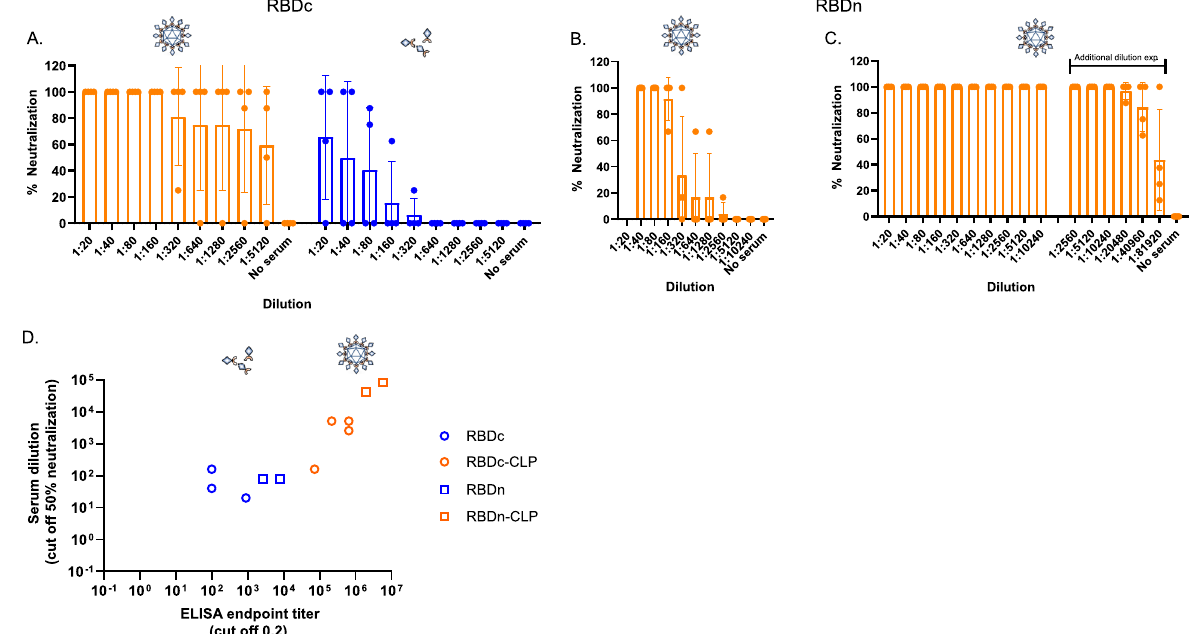
Fig. 5 Serum from mice immunized with RBD-CLP vaccines neutralizes SARS-CoV-2 in vitro. a Serum from groups of mice ( n = 4) immunized (prime 1ug/boost 1 ug) with RBDc-CLP (orange) ( n = 4) or soluble RBDc (prime 2 ug/boost 2 ug) (blue) was mixed with a SARS-CoV-2 virus and tested for cell entry. Each dot represents the percentage neutralization per mouse per dilution. Bars represent the mean and standard deviation. b , c Serum from groups of mice ( n = 4) immunized (prime 6.5 µ g/boost <0.1 µ g/boost 6.5 µ g) with RBDn-CLP obtained after the fi rst ( b ) or last ( c ) immunization was mixed with a SARS-CoV-2 virus and tested for cell entry. Each dot represents the percentage neutralization per mouse per dilution. Bars represent the mean and SD. d Correlation between ELISA IgG endpoint titer (2 nd bleed, cutoff 0.2) and the serum dilution required for 50% virus neutralization. The ELISA endpoint titers and the 50% neutralization titers were measured on the same set of serum samples obtained from groups of mice ( n = 4) immunized with RBDc ( n = 4), RBDc-CLP ( n = 4), RBDn ( n = 4) or RBDn-CLP ( n = 4) (Fig. 4a – c). Each dot represents one mouse. A Pearson r correlation was used to assess the relationship between variables.